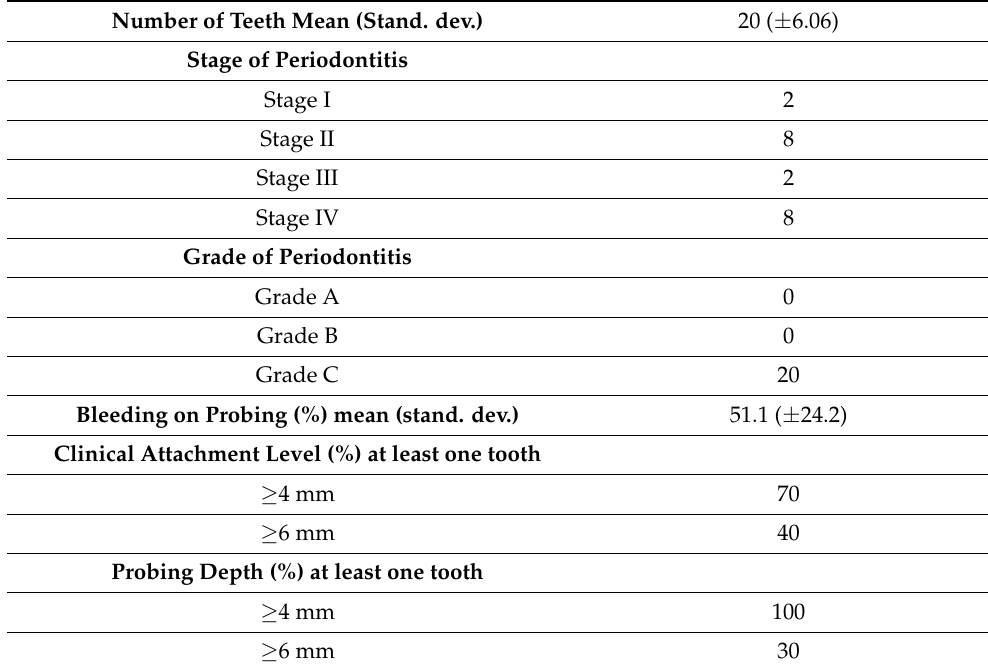
Table 2. Baseline periodontal status of the study population. Number of Teeth Mean (Stand. dev.)